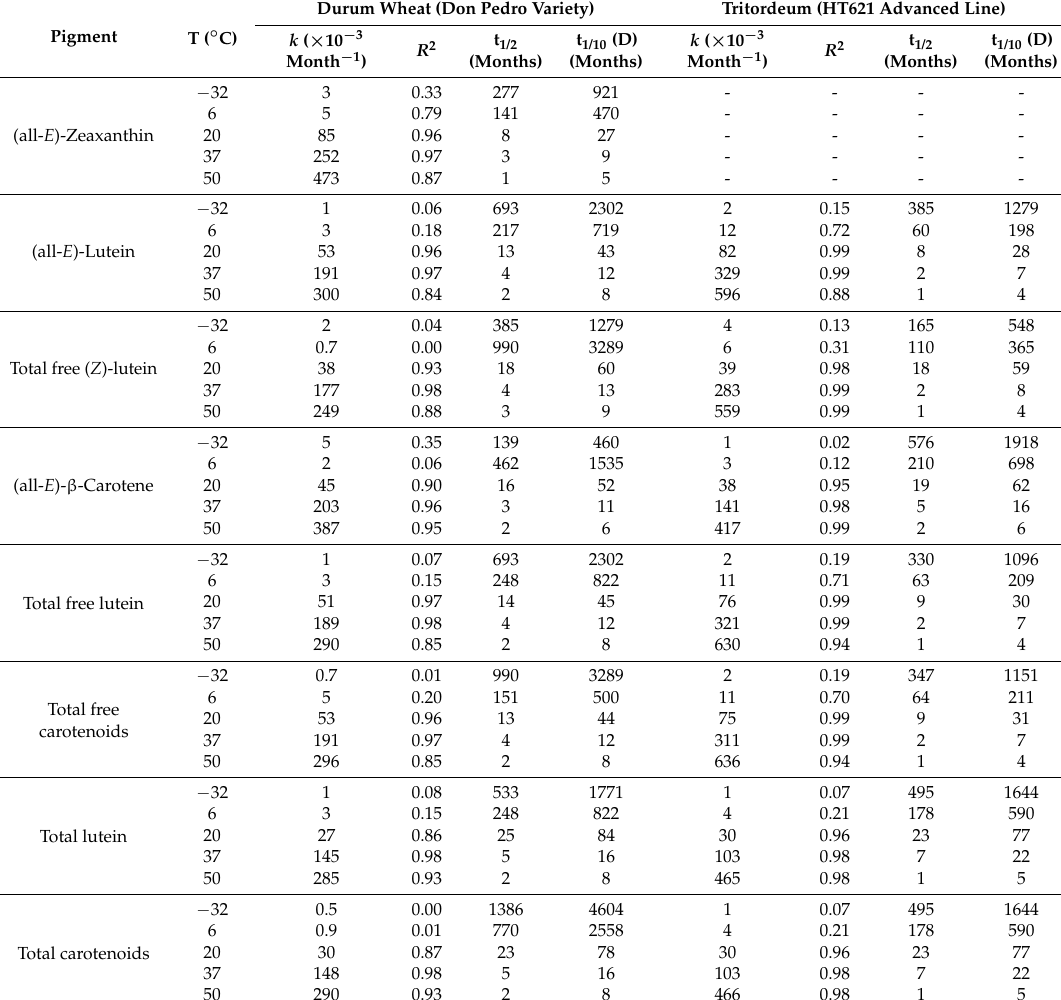
Table 4. Reaction rate constant ( k ; month − 1 ), half-life (t 1/2 ; months), and D (t 1/10 ; months) for the total carotenoid content in durum wheat (Don Pedro variety) and tritordeum (HT621 line) whole-grain flours during a long-term storage period (12 months) at − 32, 6, 20, 37, and 50 ◦ C following the first-order kinetic model (Ln( C / C 0 ) = − kt